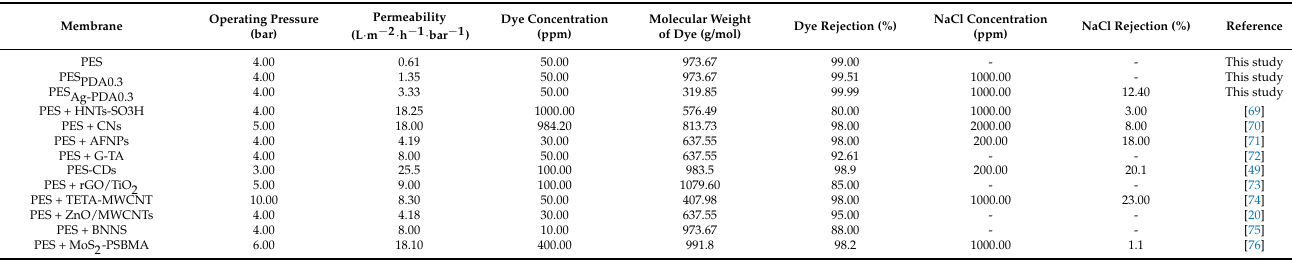
Table 4. Performance comparison of PES mixed matrix membrane of this study and other literature. Membrane